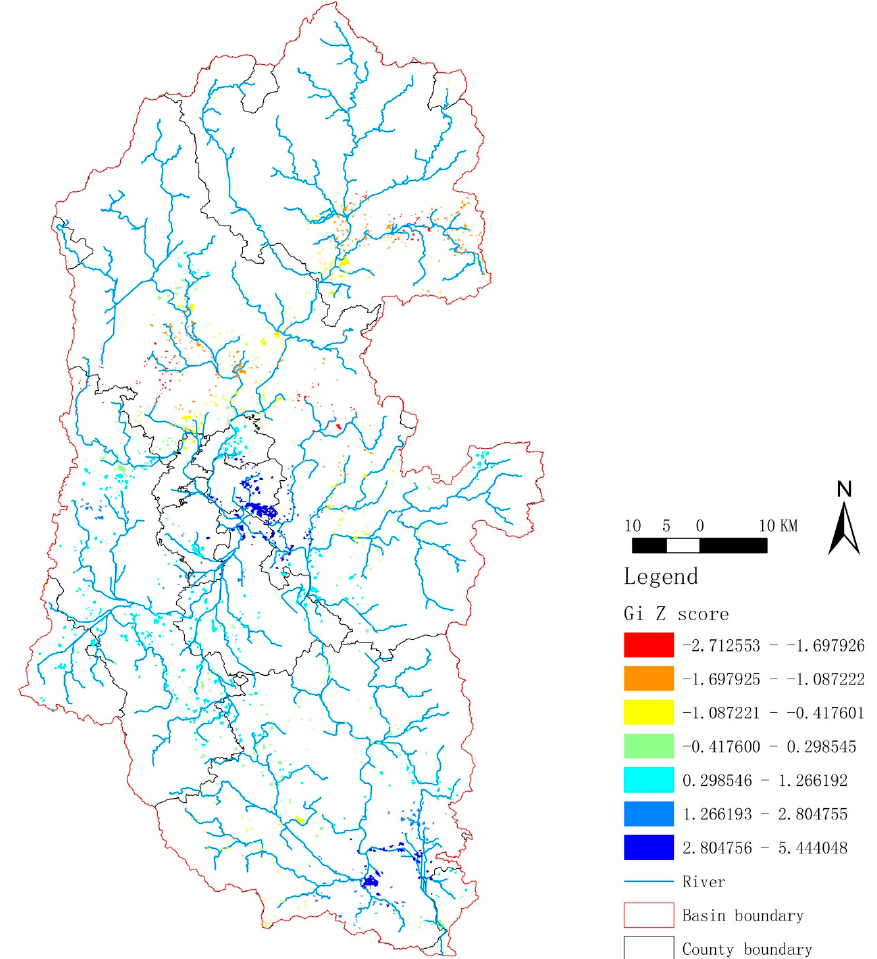
Figure 3. A hot spot plot of rural settlement in the Lijiang River Basin. The colors of the dots from red to blue indicate that the Gi Z-score gradually increased.